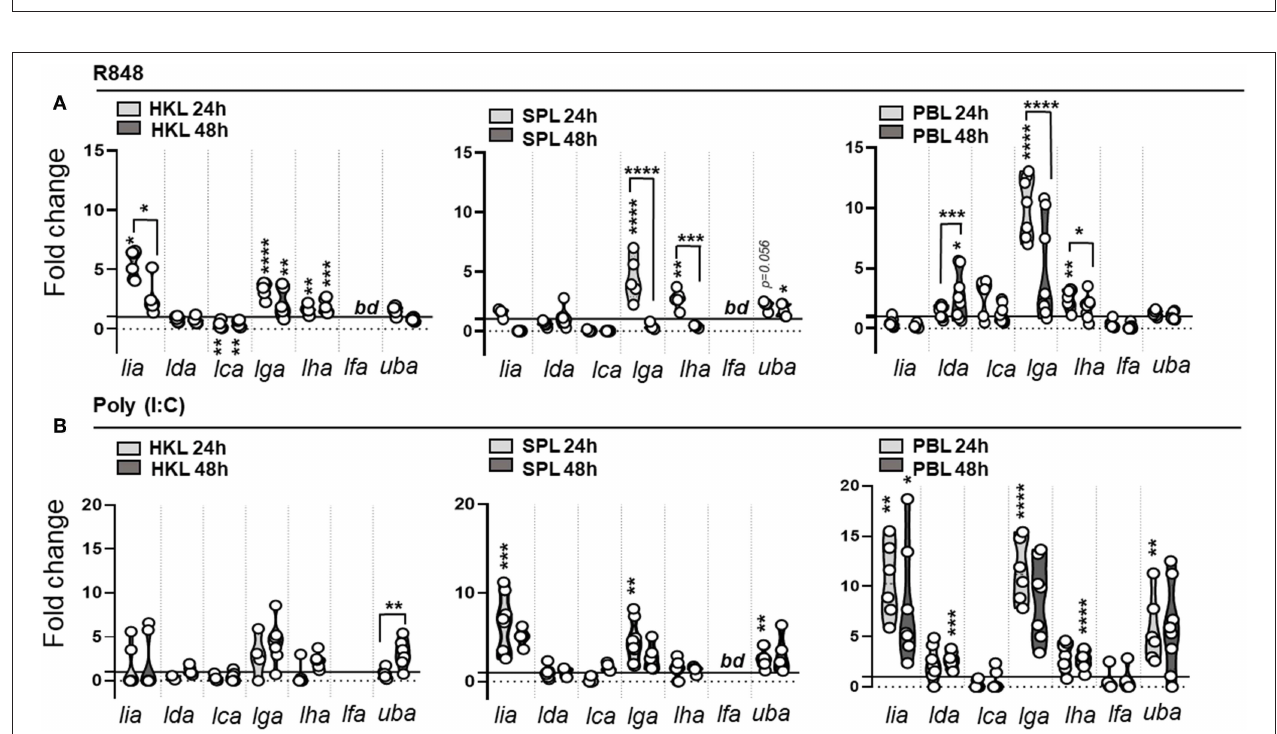
FIGURE 6 | Relative expression of MHC class I L lineage genes in freshly isolated Atlantic salmon head kidney leucocytes (HKL), spleen leucocytes (SPL), and peripheral blood leucocytes (PBL). Gene expression was analyzed by qPCR [ n ǫ (4;8)]. Data are presented as relative expression where the boxes indicate mean and SEM. Statistical significance between the different MHC class I L lineage expression levels is indicated by brackets and the asterisks indicates the strength of significance: ** p < 0.01 and **** p < 0.001.